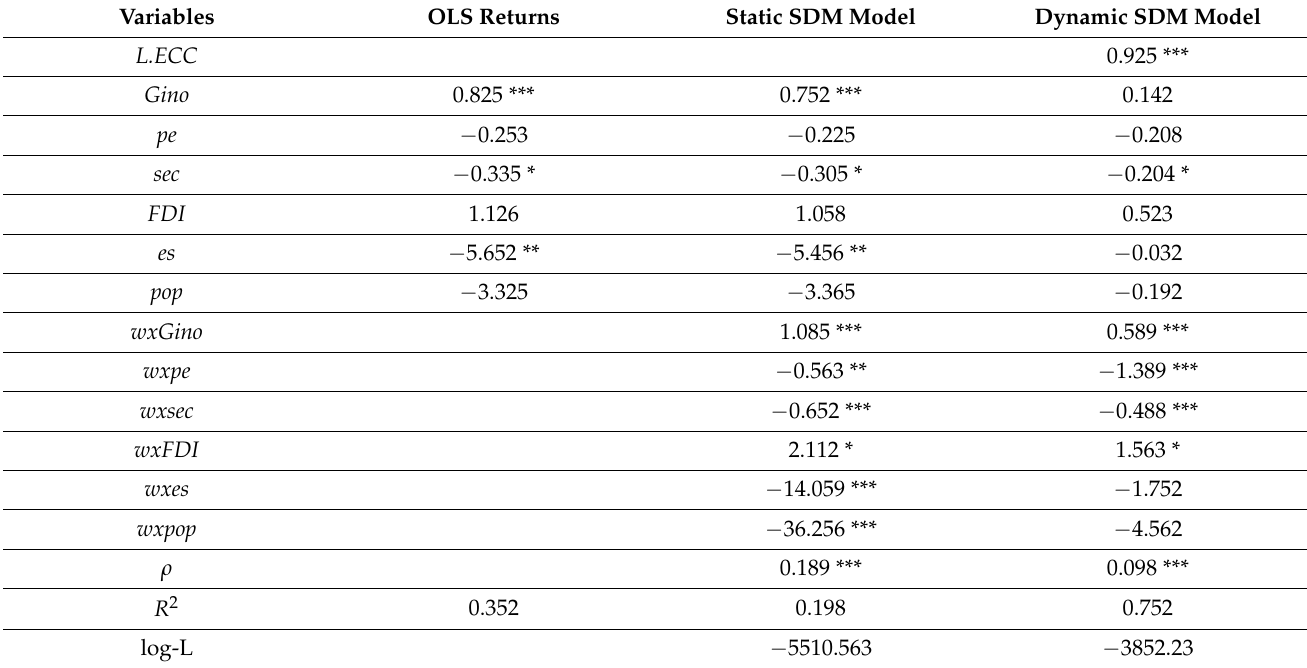
Table 5. Spatial measurement benchmark regression